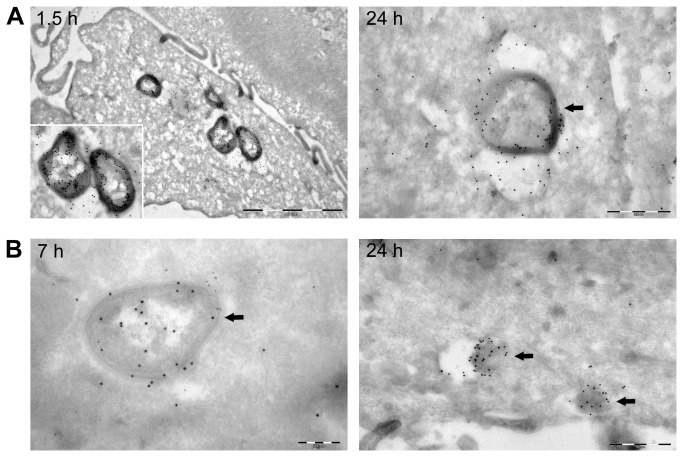
Cryoimmune electron microscopy of B. pinnipedialis HS in THP-1 and HeLa cells.Transmission electron micrographs showing uptake of B. pinnipedialis HS (B17) in THP-1 (A) and HeLa (B) cells. The cells were challenged for 1 h with bacteria as described in the materials and method section and fixed at indicated time points post infection. Bacteria or bacterial debris were labeled with a rabbit anti-Brucella antibody, and 10 nm protein-A conjugated gold particles (arrows). A) Shows intact bacteria in THP-1 cells after chase periods of 1.5 h and 24 h, respectively. B) Shows intact bacteria in a HeLa cell after a 7 h chase. At 24 h post infection the bacterial structure was to a great extent destroyed and debris labeled with anti-Brucella antibody was detected in vacuolar structures (arrows in B, 24 h chase). Scale bars: A, 1.5 h: 2 µm; A, 24 h: 500 nm; B, 7 h: 200 nm; B, 24 h: 500 nm.